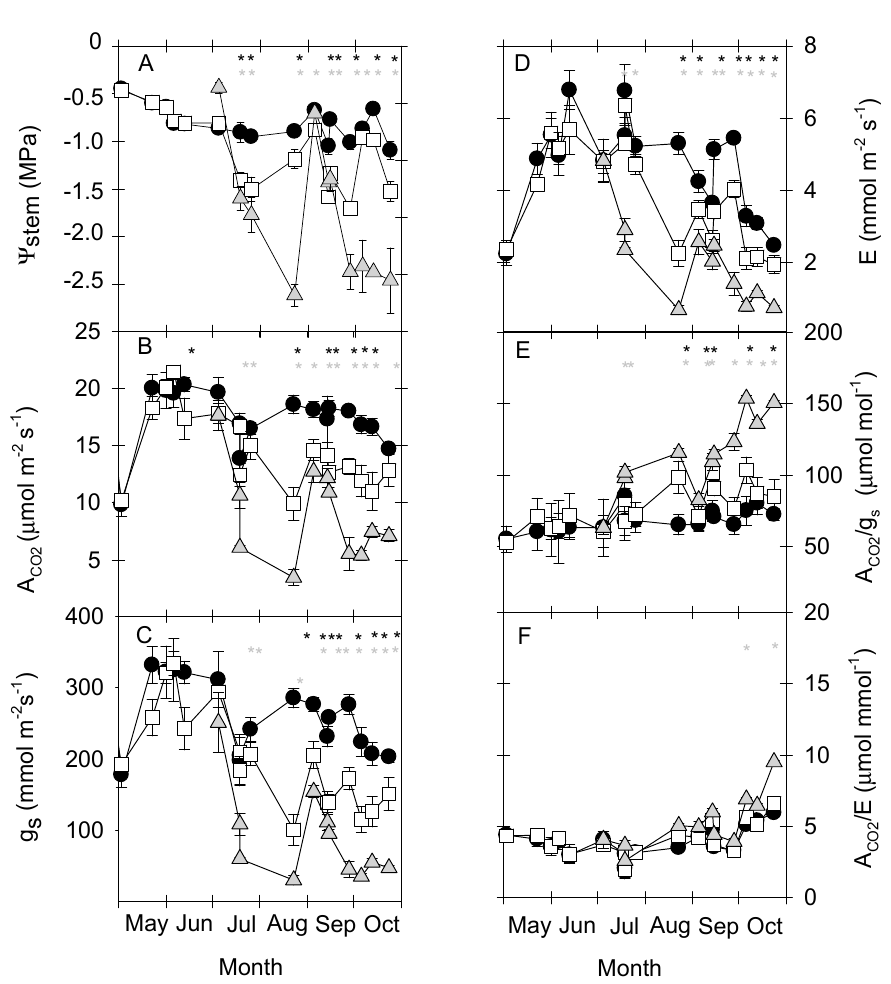
Figure 2. Seasonal trends of: (A) midday stem water potential ( Ψ stem , MPa); (B) net CO 2 assimilation rate (A CO2 , µmol m − 2 s − 1 ); (C) stomatal conductance (g s , mmol m − 2 s − 1 ); (D) transpiration rate (E, mmol m − 2 s − 1 ); (E) intrinsic water-use efficiency (A CO2 /g s , µmol mol − 1 ); and (F) instantaneous water-use efficiency (A CO2 /E, µmol mmol − 1 ), in the different irrigation treatments: T–C ( ● ), T–M ( □ ), and T–S ( ). Each point is the mean ± standard error (n = 4). Asterisks indicate statistically significant differences between T–C and T–M (black) and T–S (gray) according to LSD 0.05 .